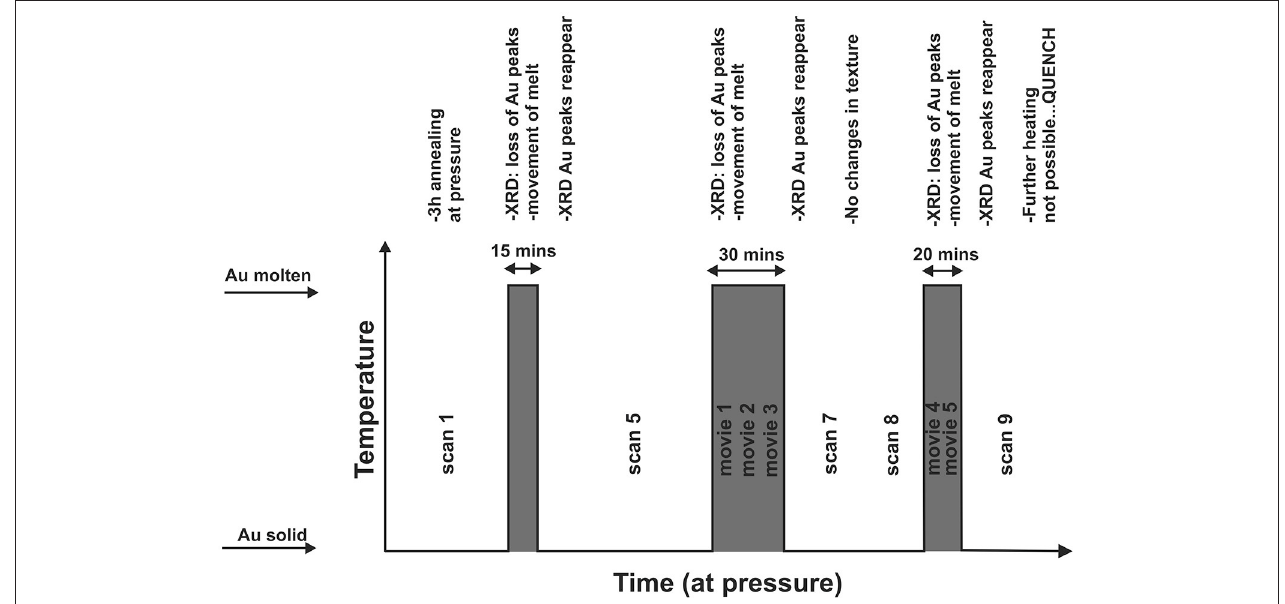
FIGURE 2 | Schematic showing details of the in-situ experiment once run pressure (3 GPa) had been attained. Vertical axis indicates temperature, which was cycled above and below the melting point of Au and the horizontal axis indicates time. “Scan” indicates relative timing of full 3-D tomographic scans obtained after heating cycles (lower temperature, when Au was solid), and “movie,” timing of 2-D radiographic movies obtained during heating cycles (higher temperature, while Au was molten). Text gives additional experimental